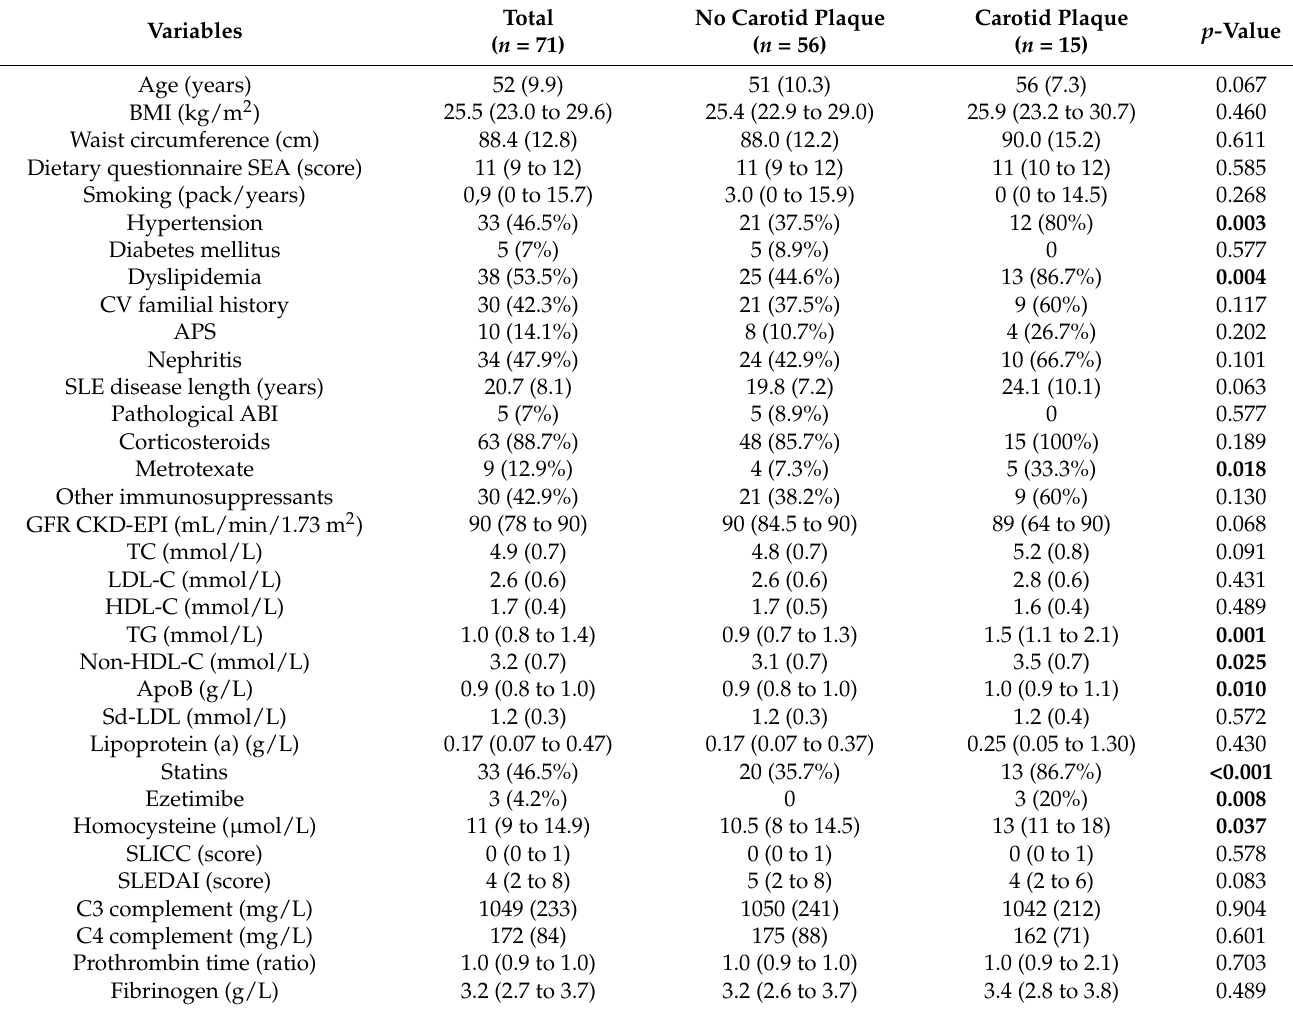
Table 1. Baseline characteristics of the patients included in the